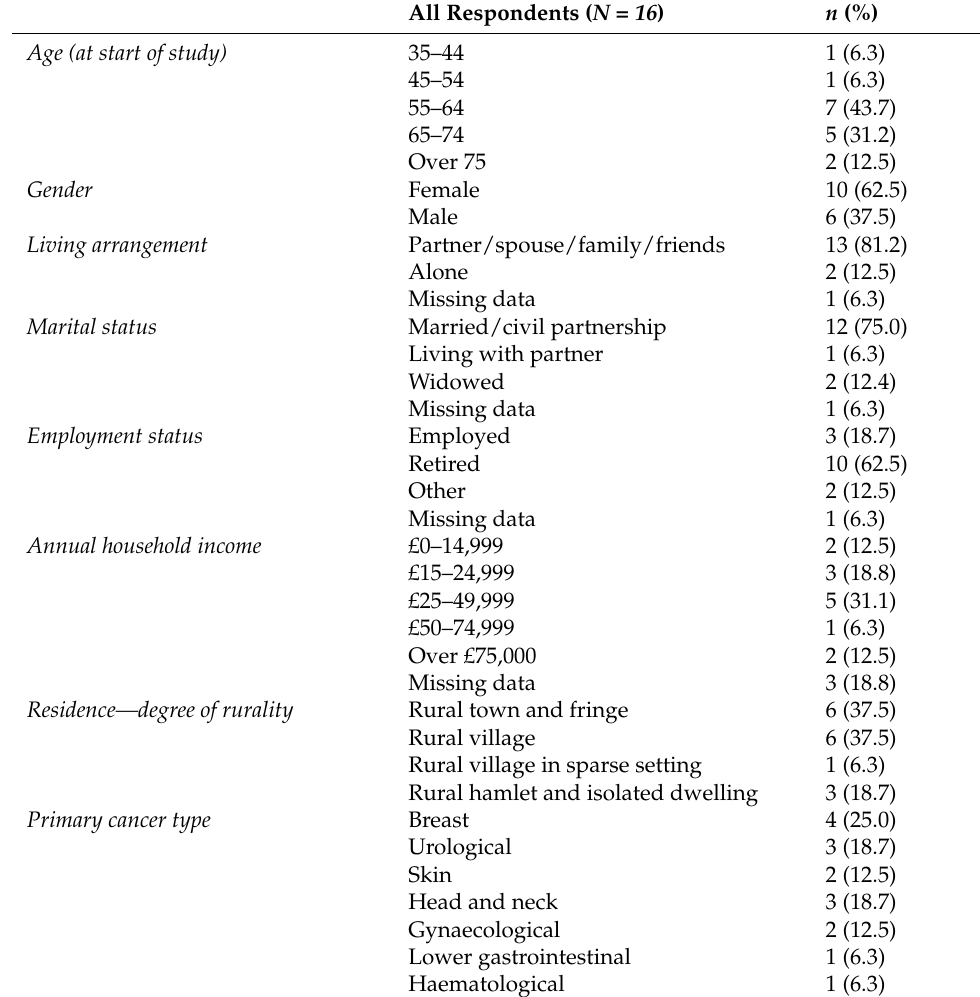
Table 2. Socio-demographic profile of